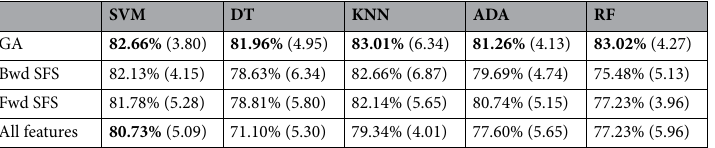
Table 3. Best accuracy for each ML model—with expert’s opinion as input. Standard deviation (STD) is included in parentheses. Significant values are in bold.